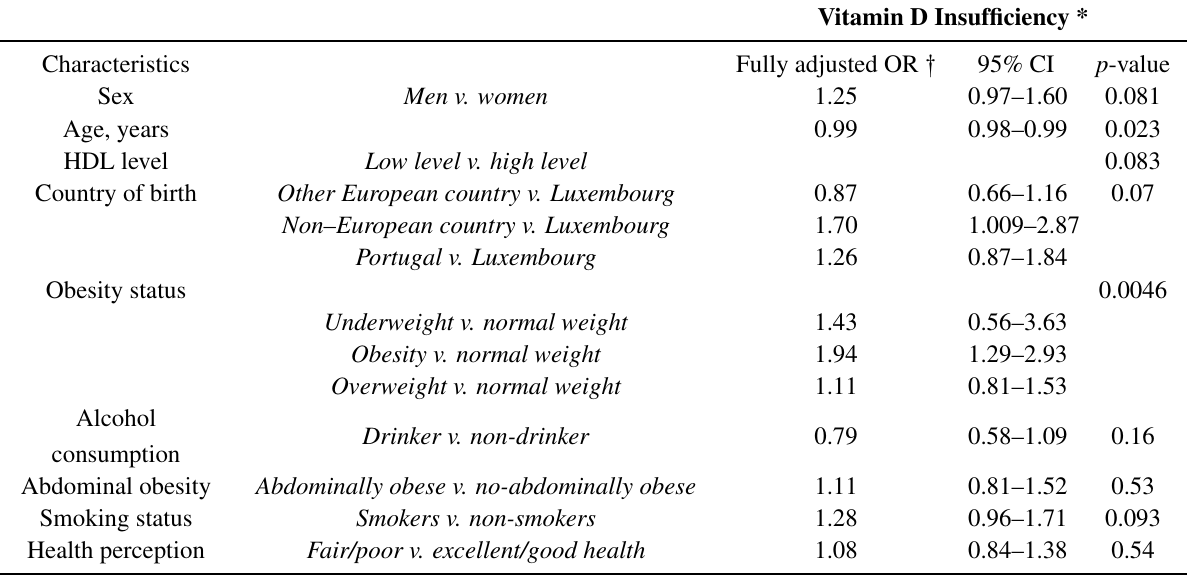
Table 3. Independent demographic, socioeconomic, and behavioral correlates of vitamin D insufficiency in adults’ participants to the ORISCAV-LUX study, as identified by multivariate logistic regression ( n = 1277